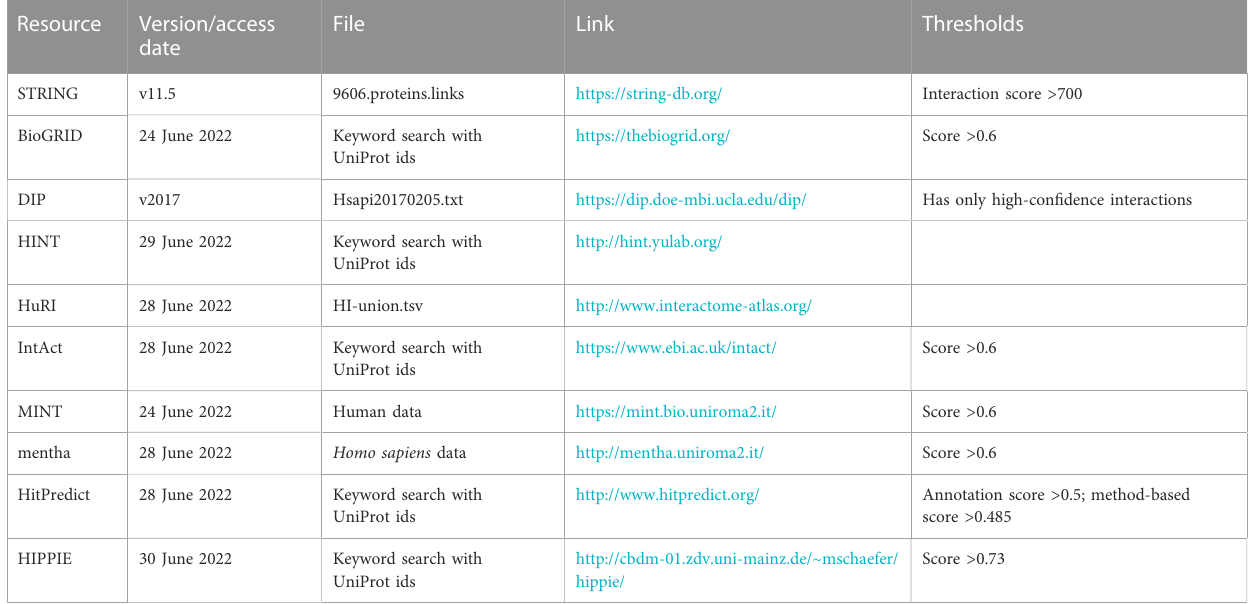
TABLE 2 List of protein – protein interaction works used in the